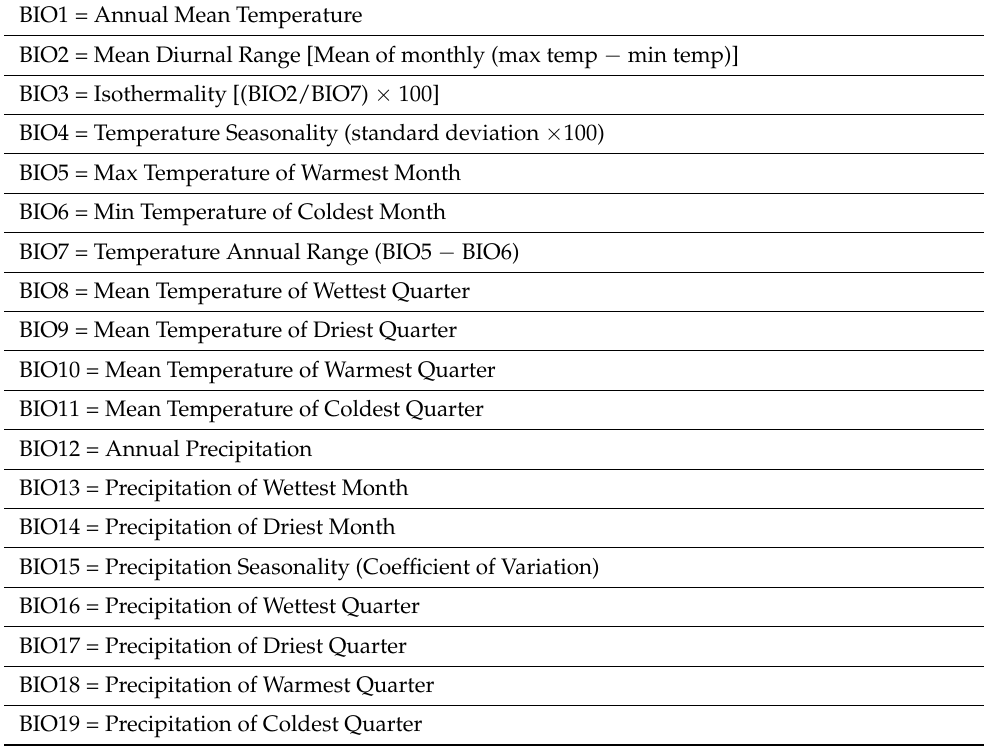
Table A1. Definitions of the Nineteen Bioclimatic